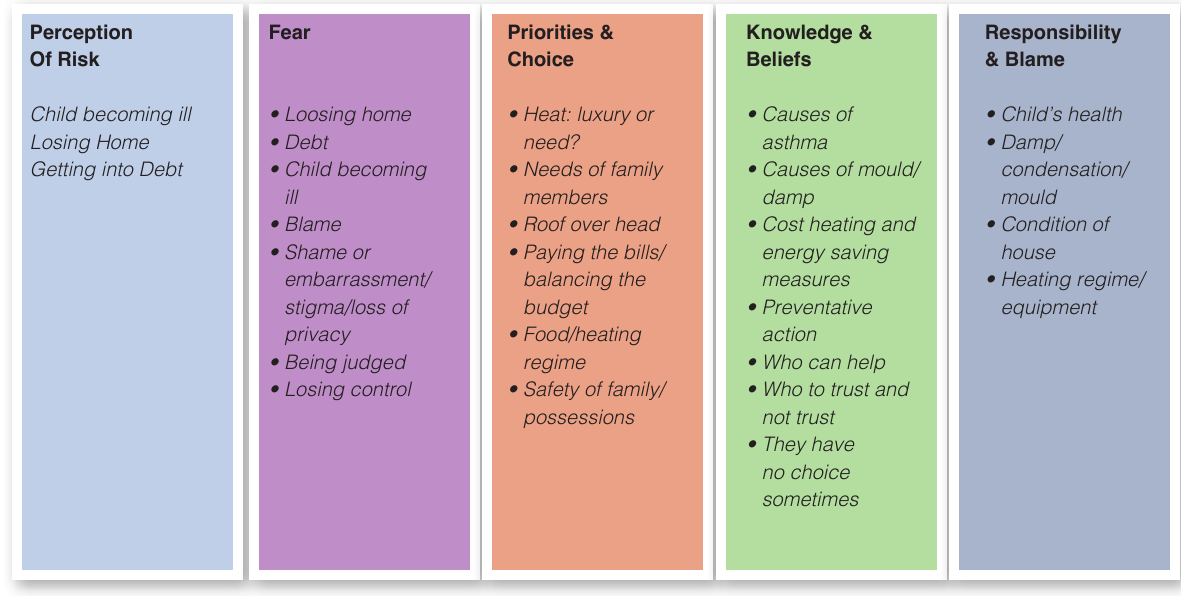
Figure 5. The psychological